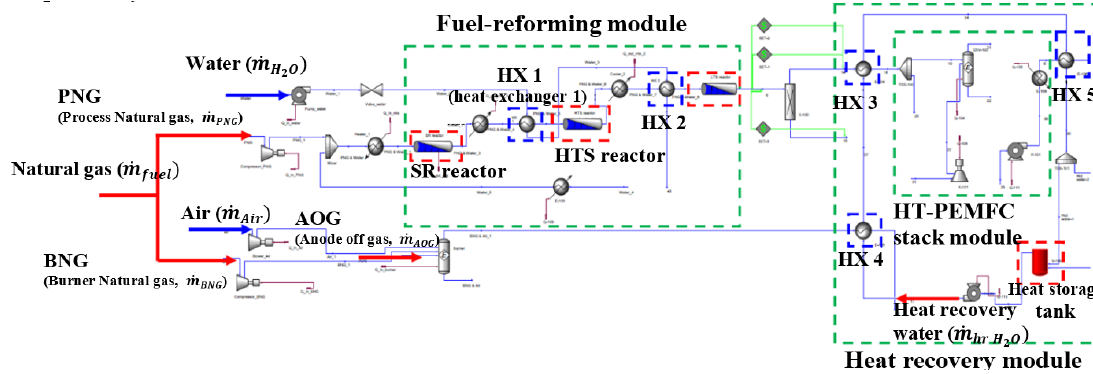
Figure 5. Flowsheet of the heat recovery module created by ASPEN HYSYS ® , wherein the roles of five heat exchangers are schematically illustrated.